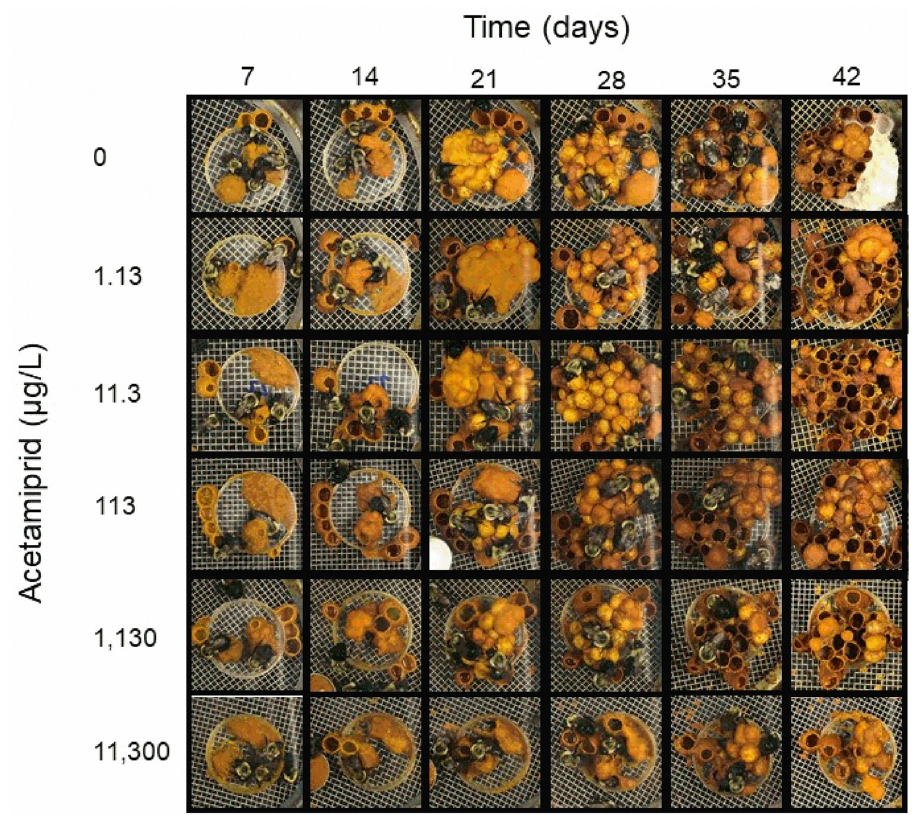
Fig 3. Concentration-related impacts of acetamiprid on microcolony growth and development. Representative photographs of microcolony development from week one (day 7) to experiment termination on day 42 in the presence of acetamiprid-containing sugar syrup. Representative photographs are shown from one of the ten microcolonies per treatment.